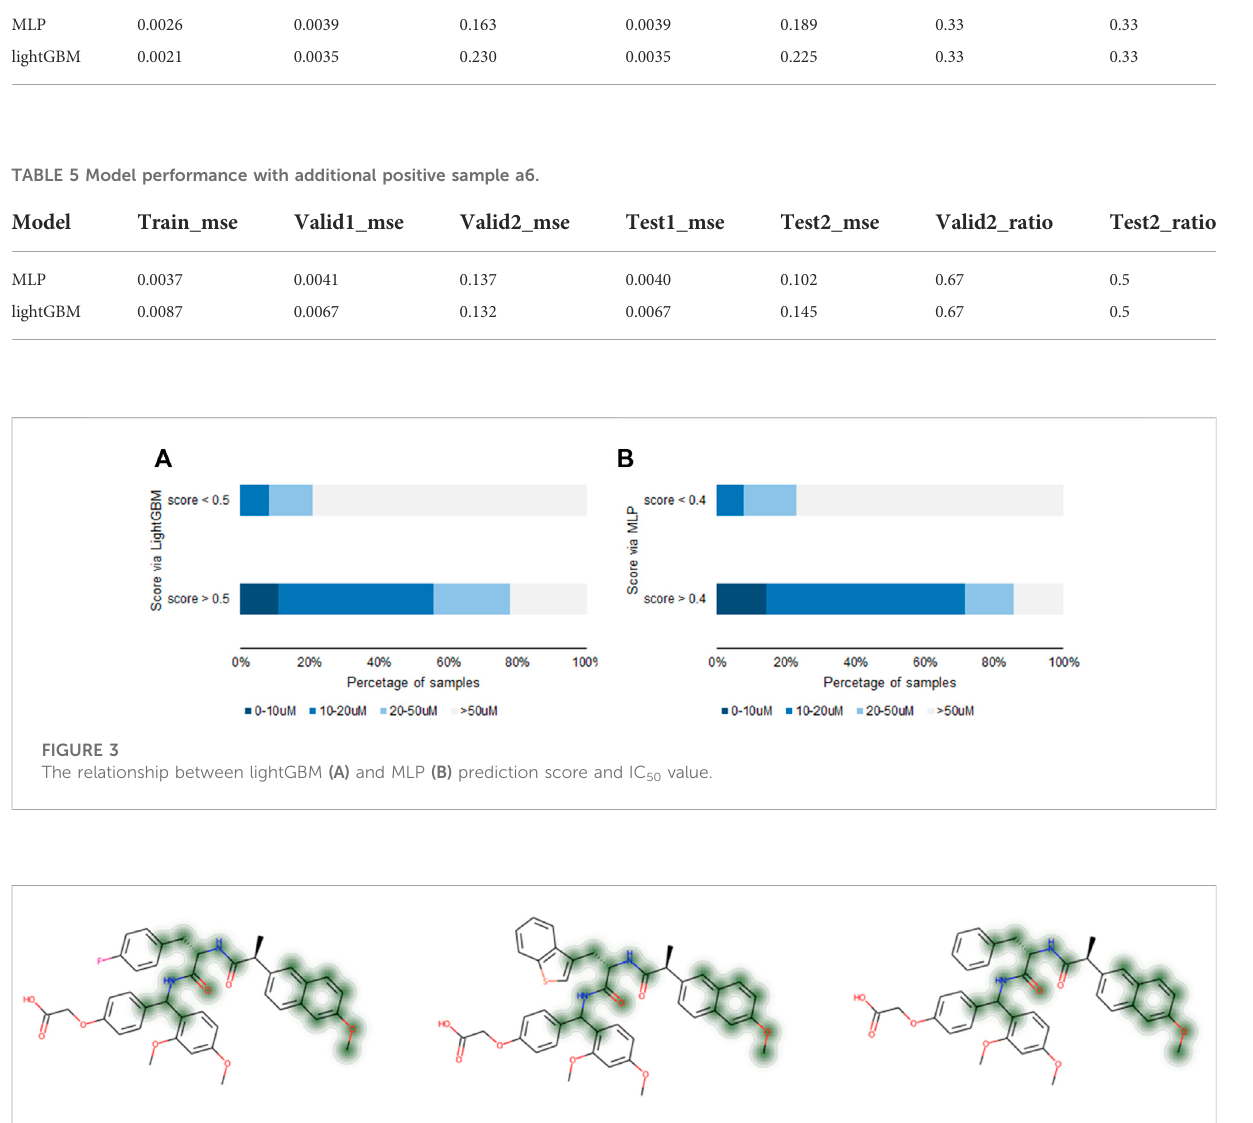
FIGURE 4 Gaussian distribution of compounds with high predicted